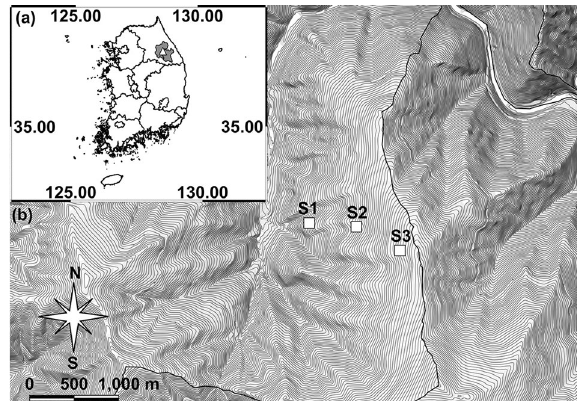
Figure 1. Location of the study area. ( a ) Location of Mt. Gariwang (white triangle) in Pyeongchang and Jeongseon (grey); ( b ) location of the three study sites (white box) in Mt. Gariwang. Both ( a ) and ( b ) were generated using QGIS 3.16 (http:// www. qgis.